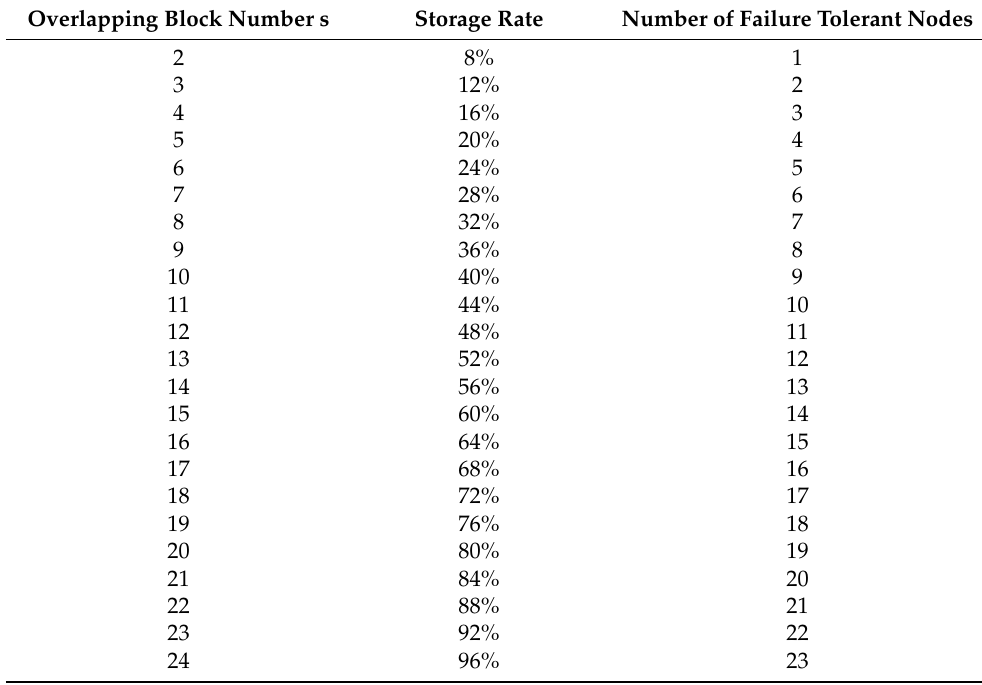
Table 3. Storage ratios and the number of tolerant failure nodes. Overlapping Block Number